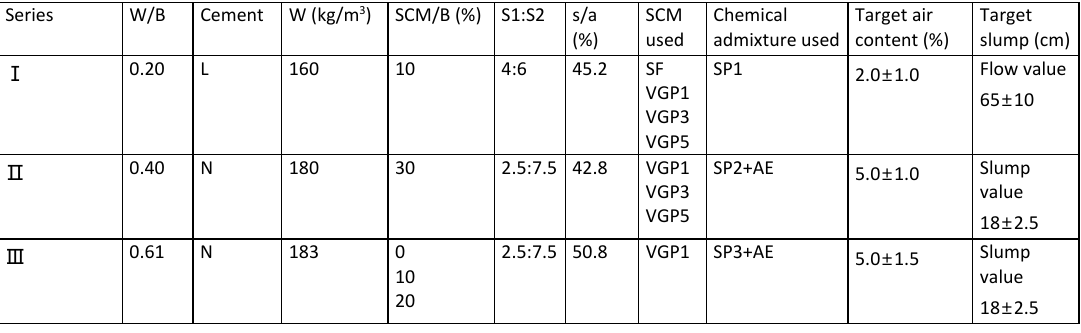
Table 5. Factors and level, mixing proportions.